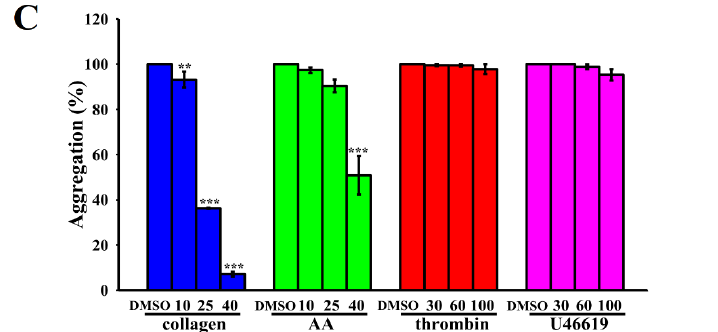
Figure 1. Inhibitory effects of glabridin on platelet aggregation stimulated by different agonists in human platelets. ( A ) Chemical structure of glabridin (C 20 H 20 O 4 ). ( B ) Washed human platelets (3.6 × 10 8 cells/mL) were preincubated with a solvent control (0.1% DMSO) or glabridin (10–100 μM) and subsequently treated with collagen (1 μg/mL), thrombin (0.01 U/mL), U46619 (1 μM), or arachidonic acid (AA; 60 μM) to stimulate platelet aggregation. ( C ) Concentration–response histograms of glabridin’s effects on platelet aggregation triggered by various agonists (%). Data are presented as mean ± standard error of the mean (n = 4). ** p < 0.01 and *** p < 0.001 vs. 0.1% DMSO-treated group.